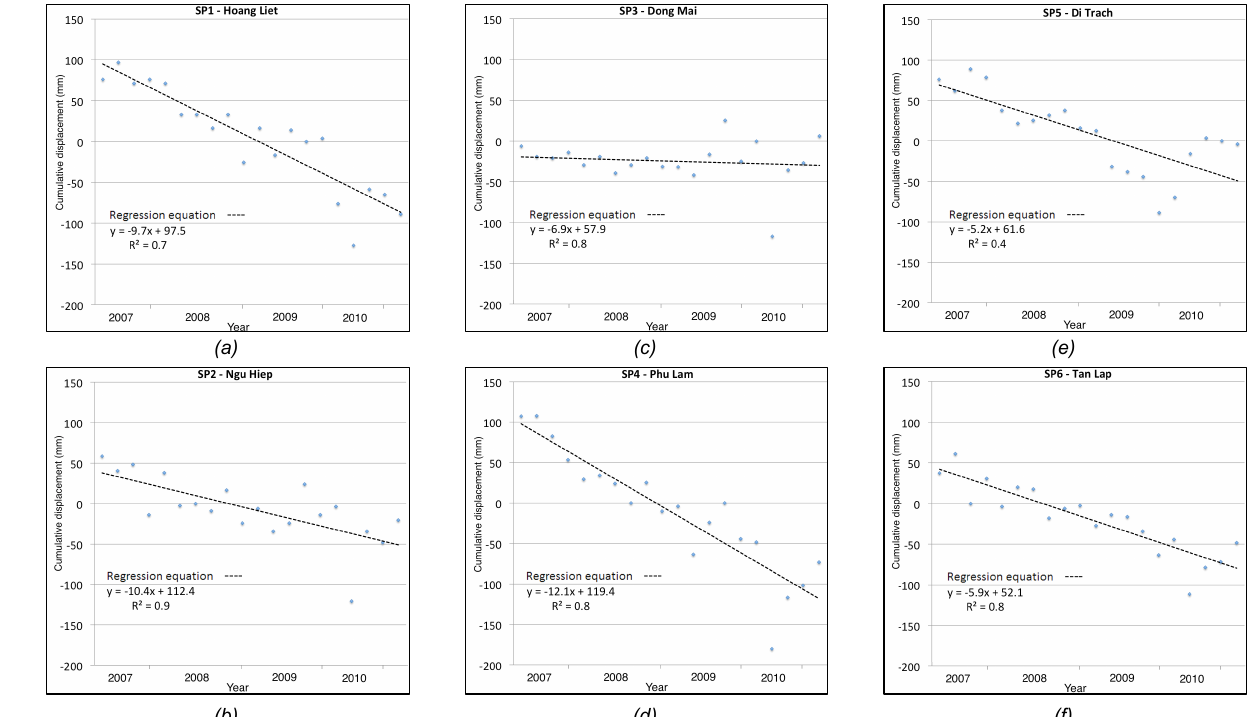
Fig. 5 : Time series of vertical displacement at several SP pixels at ( a ) Hoang Liet, Hoang Mai, ( b ) Ngu Hiep, Thanh Tri, ( c ) Dong Mai, Ha Dong ( d ) Phu Lam, Ha Dong, ( e ) Di Trach, Hoai Duc, ( f ) Tan Lap, Hoai Duc. For location of SP sampling points, refer to Fig. 4. Fig. 5. Time series of vertical displacement at several SP pixels at (a) Hoang Liet, Hoang Mai, (b) Ngu Hiep, Thanh Tri, (c) Dong Mai, Ha Dong (d) Phu Lam, Ha Dong, (e) Di Trach, Hoai Duc, (f) Tan Lap, Hoai Duc. For location of SP sampling points, refer to Fig.